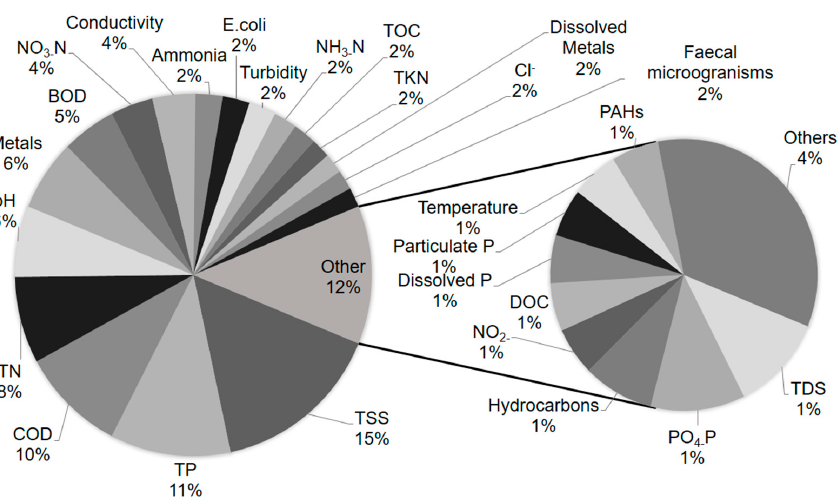
Figure 6. Distribution of the typical water quality parameters monitored in the reviewed research articles related to first